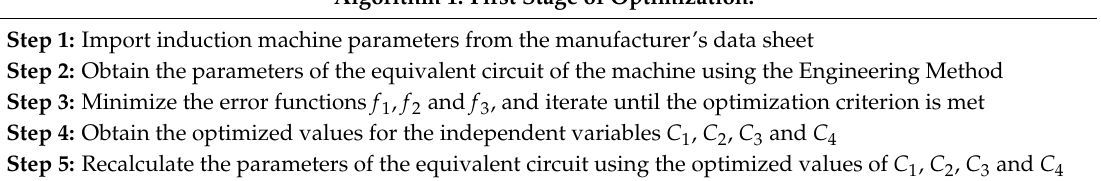
Algorithm 1: First Stage of Optimization.